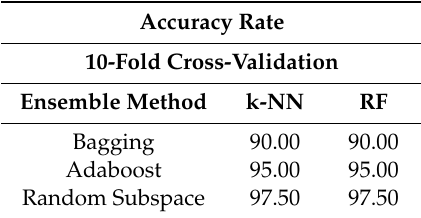
Table 6. Overall performance measure ensemble classifiers for 10-fold cross validation method.